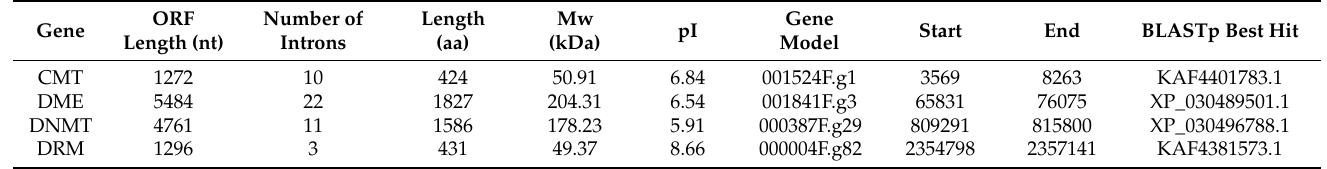
Table 1. Characteristics of the identified DNA methylases and demethylases in the hop’s draft ge- nome.